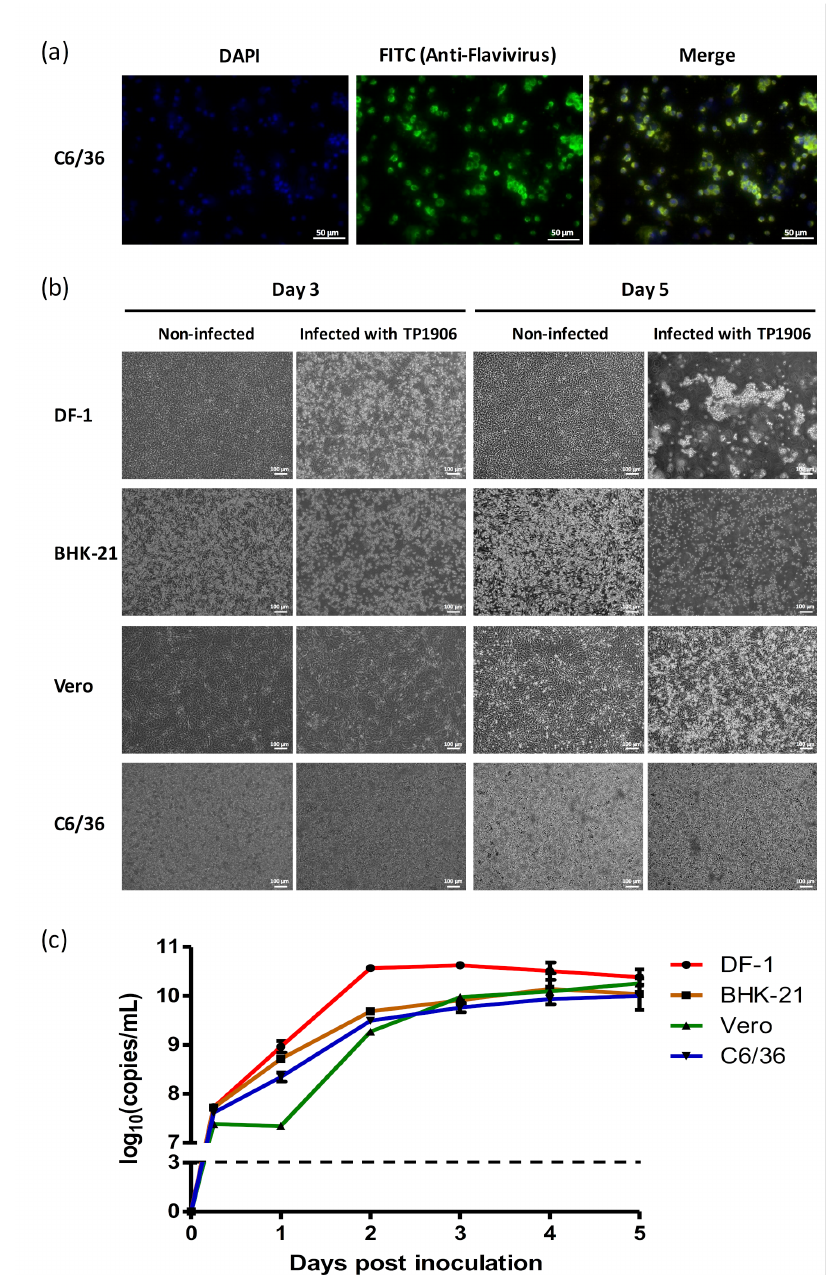
Figure 2. Di ff erent cell lines were permissive to TMUV-TP1906 infection. ( a ) The TMUV-TP1906 infection was detected by IFA in C6 / 36 cells. ( b ) The morphology of TMUV-TP1906 infected cells at 3 days and 5 days postinfection. ( c ) Growth curves of TMUV-TP1906 in di ff erent cell lines. All the experiments were performed in triplicate. Dashed line indicates the limit of detection of real time RT-PCR by using the flavivirus-specific primer